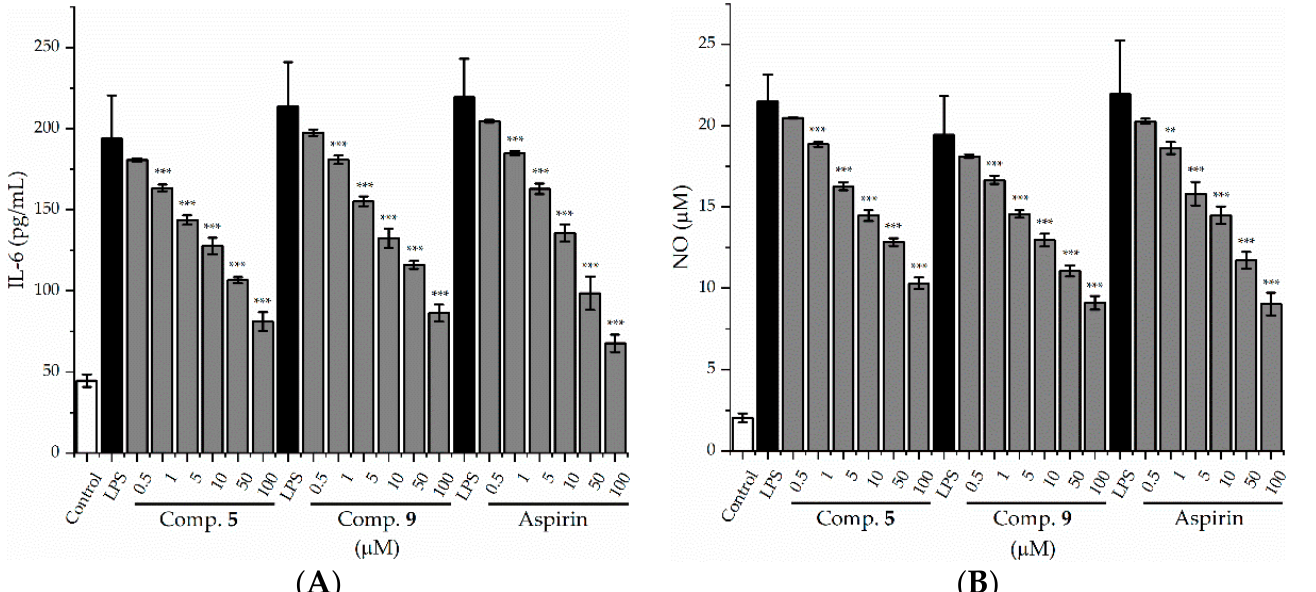
Figure 4. Effects of compounds 5–7 and 9 on TNF- α production in LPS-stimulated raw 264.7 cells. * p < 0.05, ** p < 0.01, and *** p < 0.001 compared with LPS-stimulated group. Aspirin (positive control).